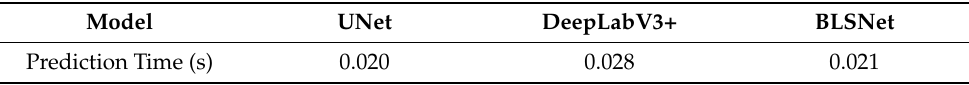
Table 4. Model prediction time comparison.